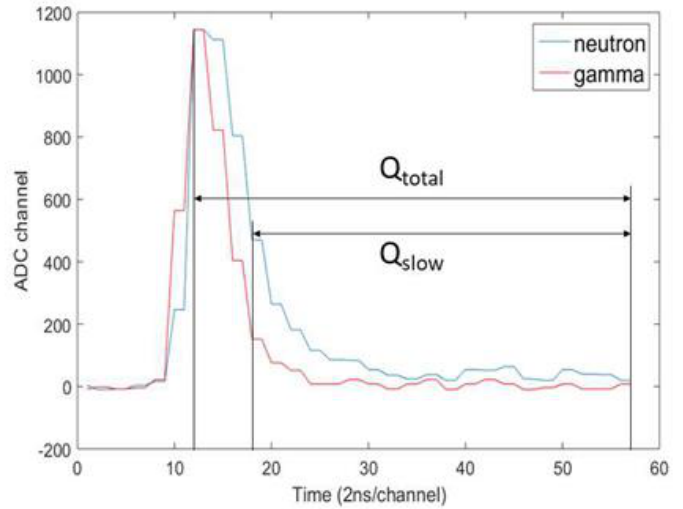
Figure 15. Neutron/gamma-ray signal of the EJ-301 detector with a charge comparison method applied